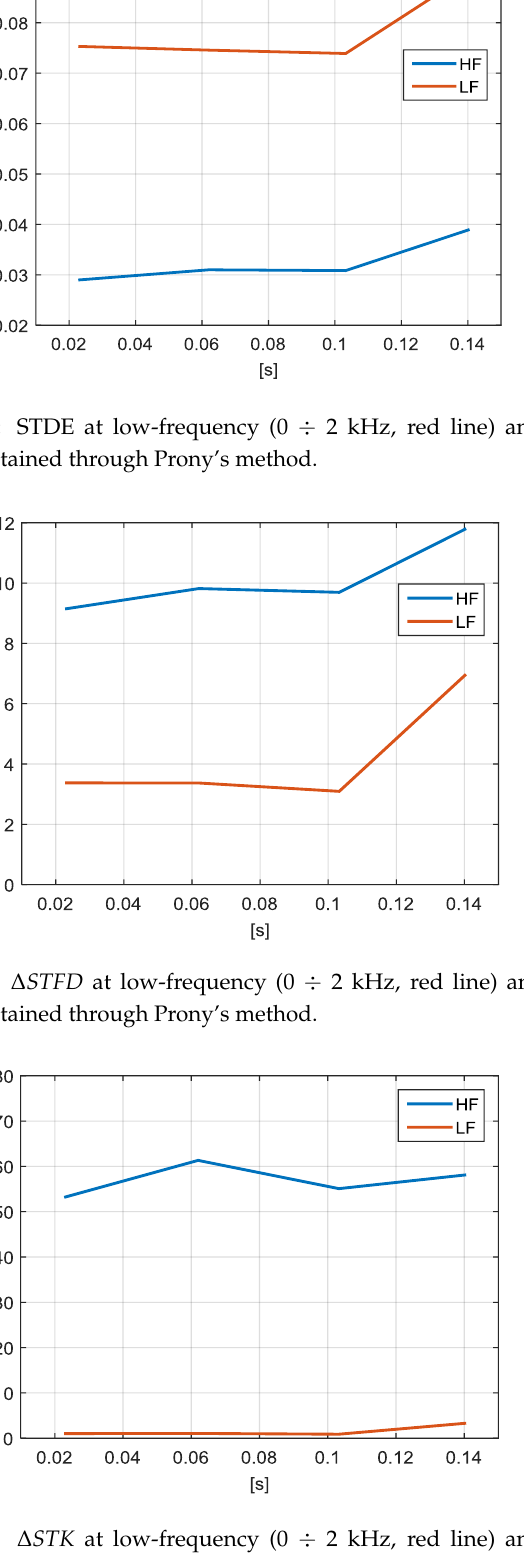
Figure 33. Case study 2: Δ STK at low-frequency (0 ÷ 2 kHz, red line) and at high-frequency (2 ÷ 150 kHz, blue line) obtained through STFT.